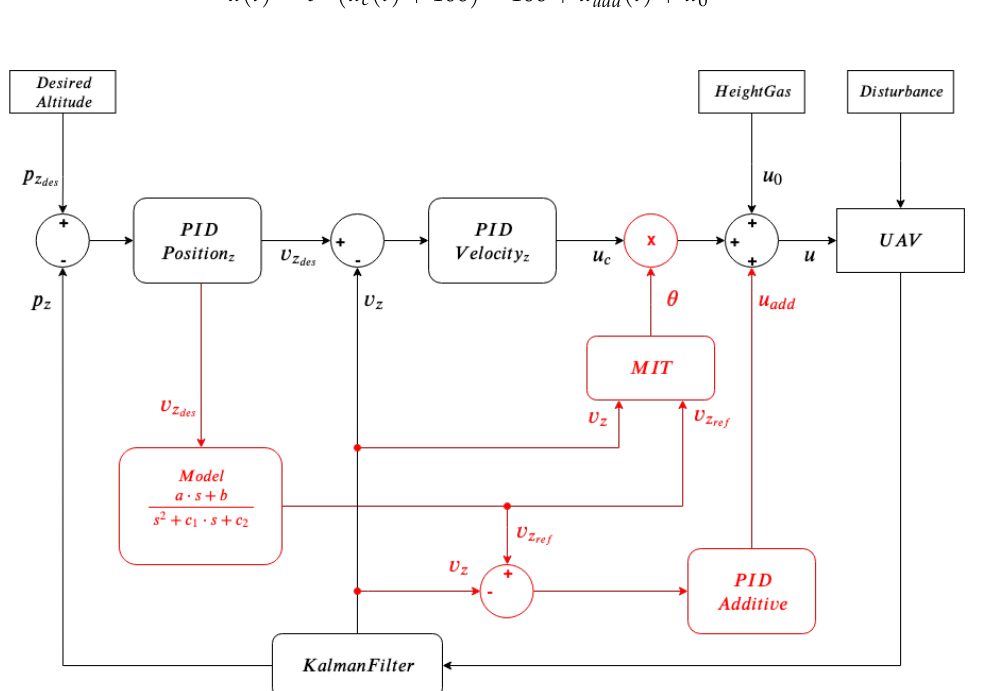
Figure 3. Diagram of the implemented modified